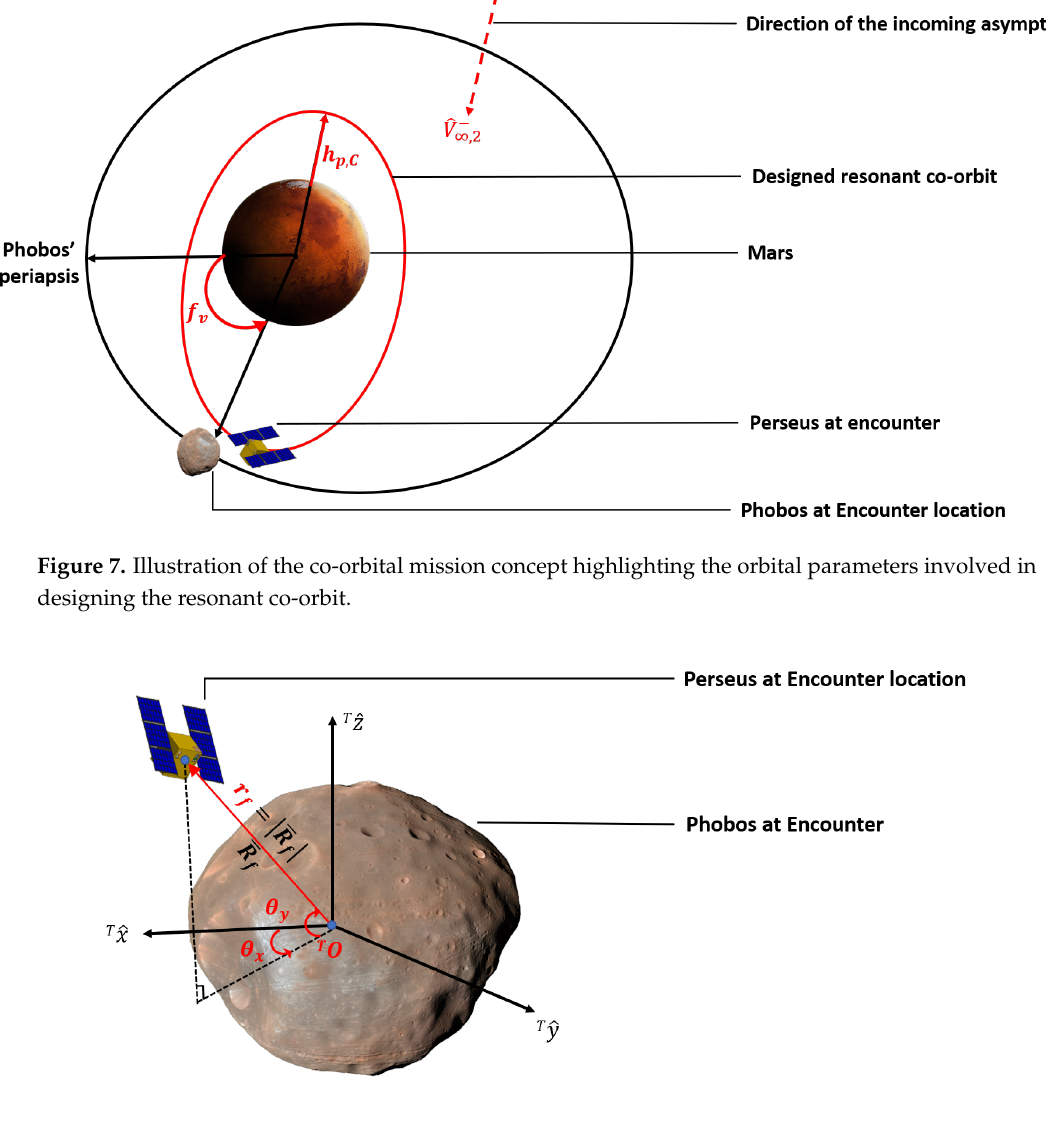
Figure 8. Illustration of the geometrical parameters required to define the spacecraft location with respect to Phobos during an